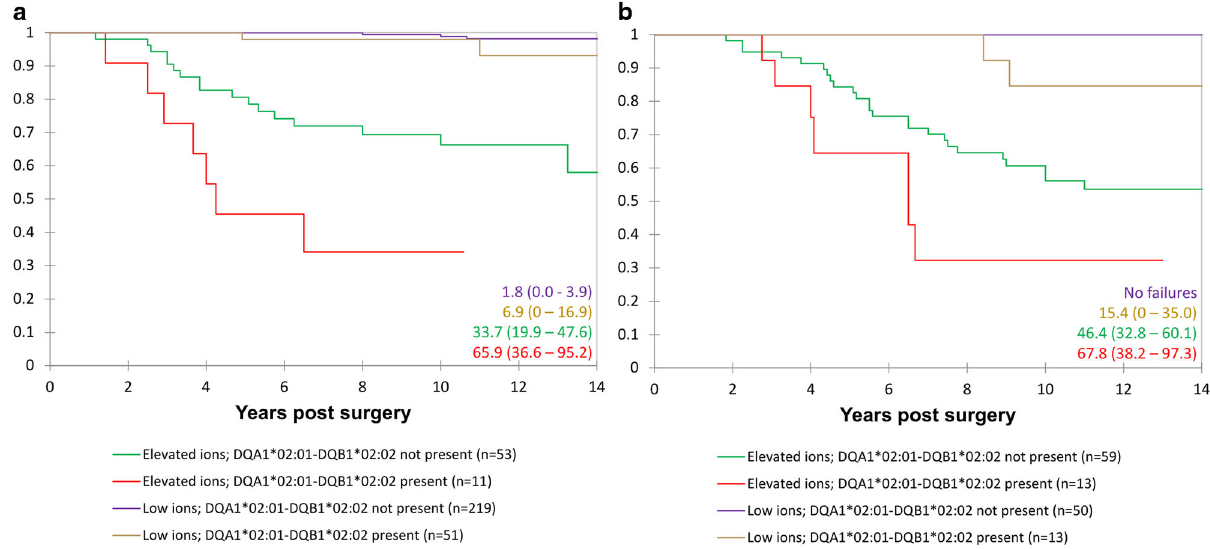
Fig. 5 Kaplan – Meier survival analysis including all patients in the study. a Male patients. b female patients. Failure de fi ned as revision secondary to ALVAL (moderate or severe). The patients have been sub-divided according to implant type (hip resurfacing or THR) and genotype (possession of HLA- DQA1*02:01-DQB1*02:02). Failure rates at 12 years are shown at the bottom right of the charts (with 95% con fi dence